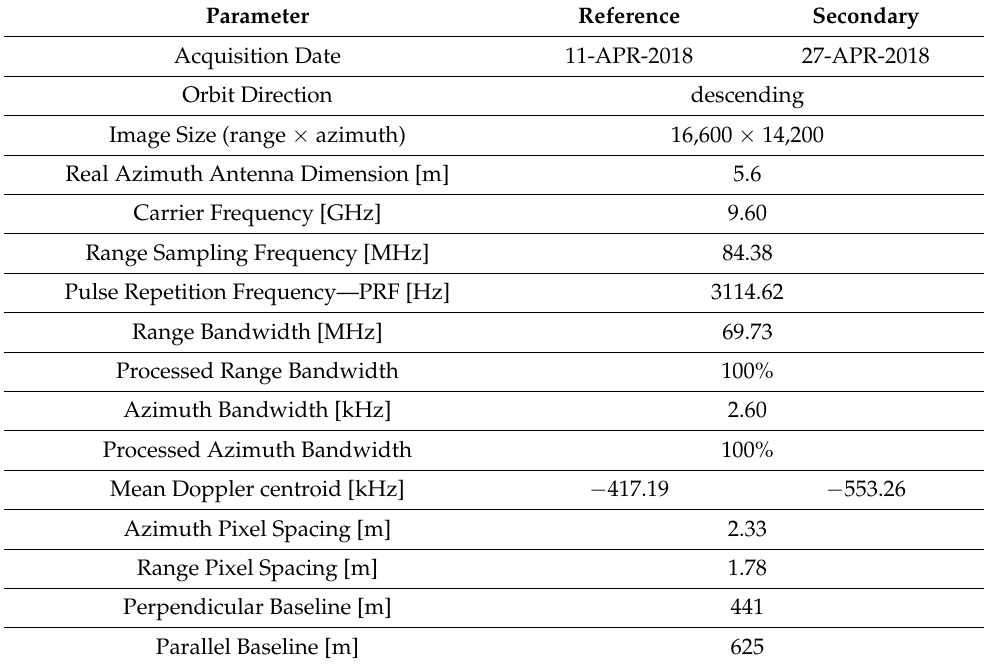
Table 1. Parameters of the SAR